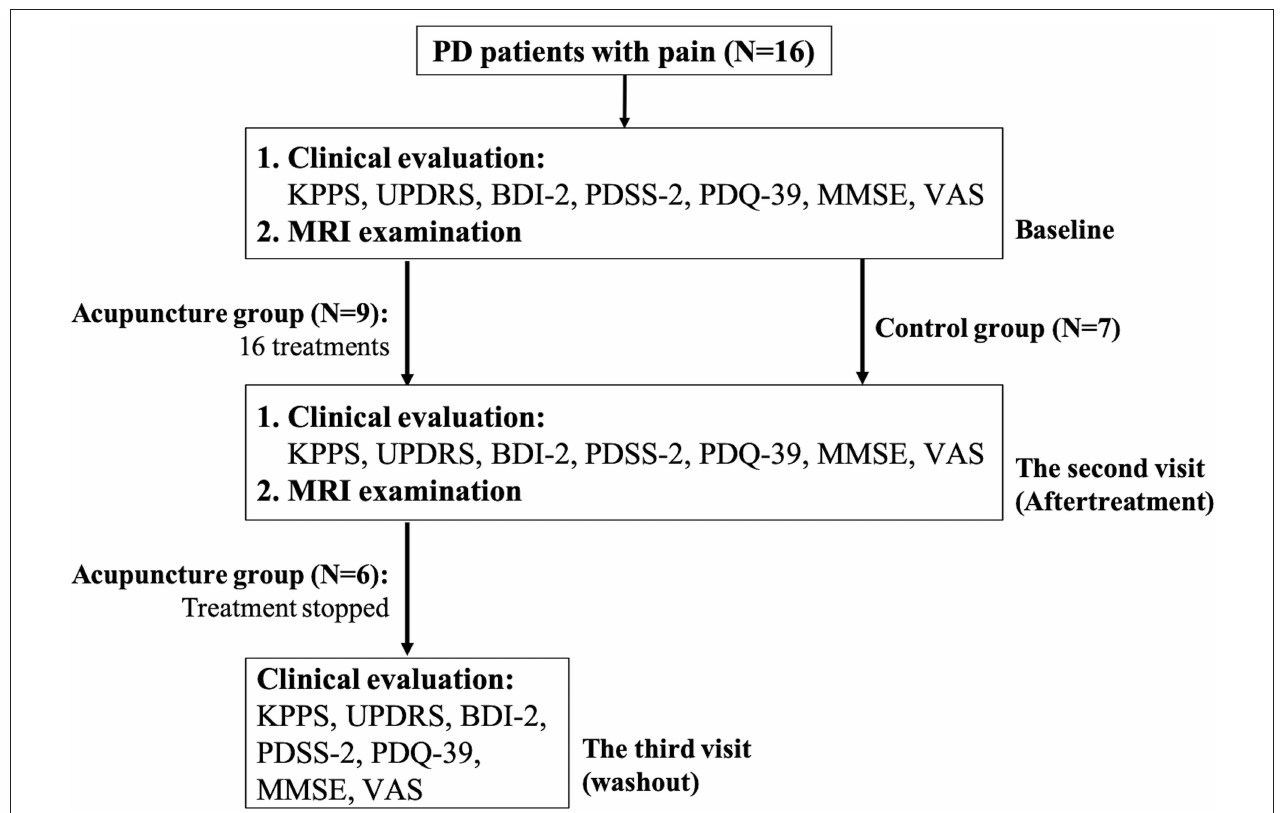
FIGURE 1 | Flow chart of the current study. Patients with PD who had pain were consecutively enrolled and were divided into two groups according to their wish. If they expressed their wish to receive acupuncture therapy, they would be assigned to the acupuncture group. If they preferred not, they would be enrolled as control upon entering the study. All patients underwent clinical evaluations and their first MRI examination at baseline; patients in the treatment group and control group received the second clinical evaluation and MRI examination after 16 acupuncture treatments and 10–14 weeks after the first examination, respectively. The patients in the acupuncture group underwent the third evaluation, three months after stopping acupuncture treatment.